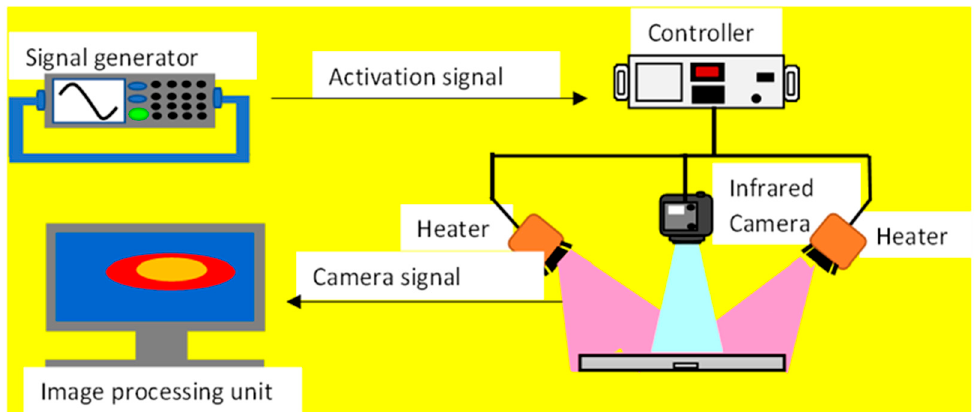
Figure 3. The basic principle of infrared thermography for defect detection.